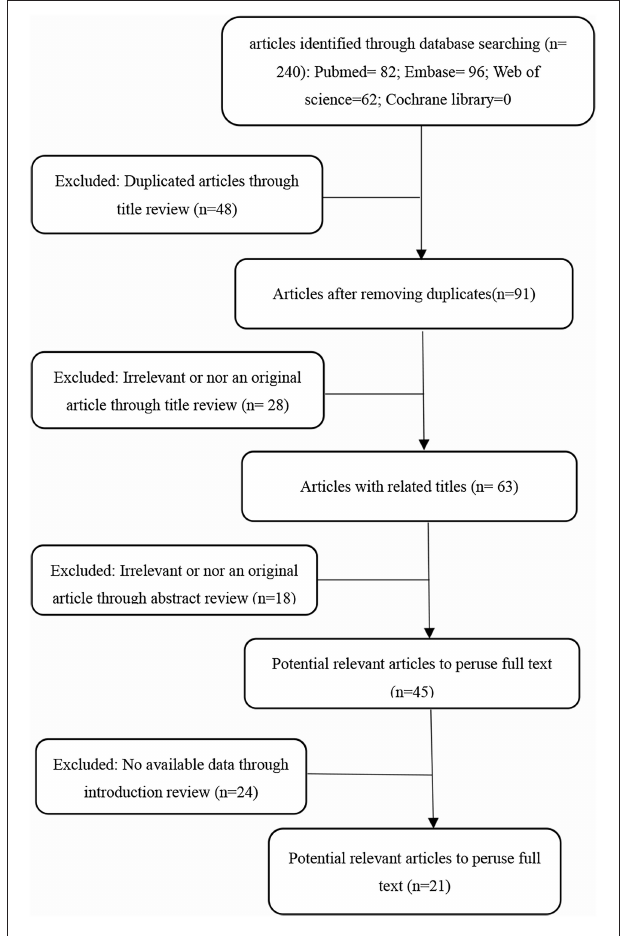
FIGURE 1 | Flow diagram of this